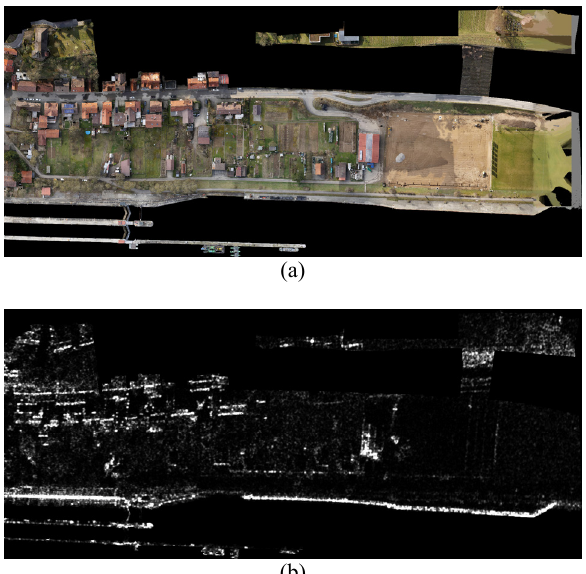
Figure 2 . Data obtained by pre-processing for (a) top-view image, and (b) SAR image.